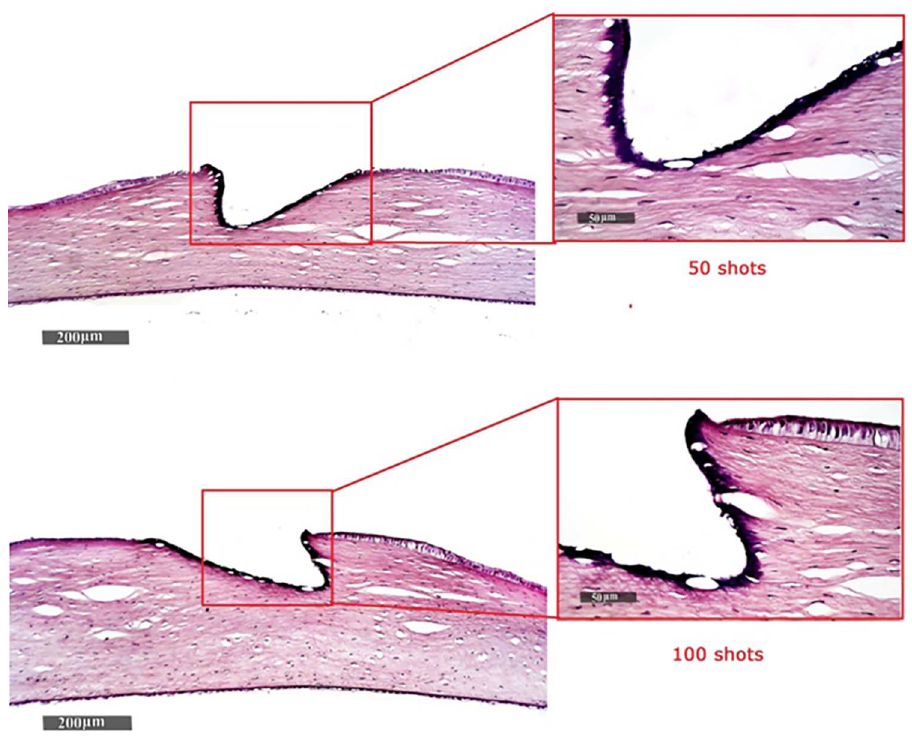
Fig 8. Histopathologic changes of corneal tissue after applying laser pulses. (a) 50 pulses, and (b) 100